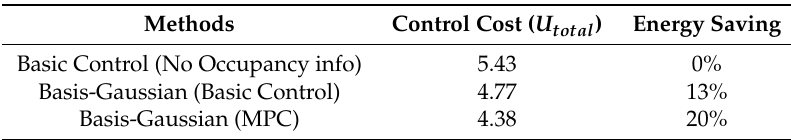
Table 6. Comparison of energy